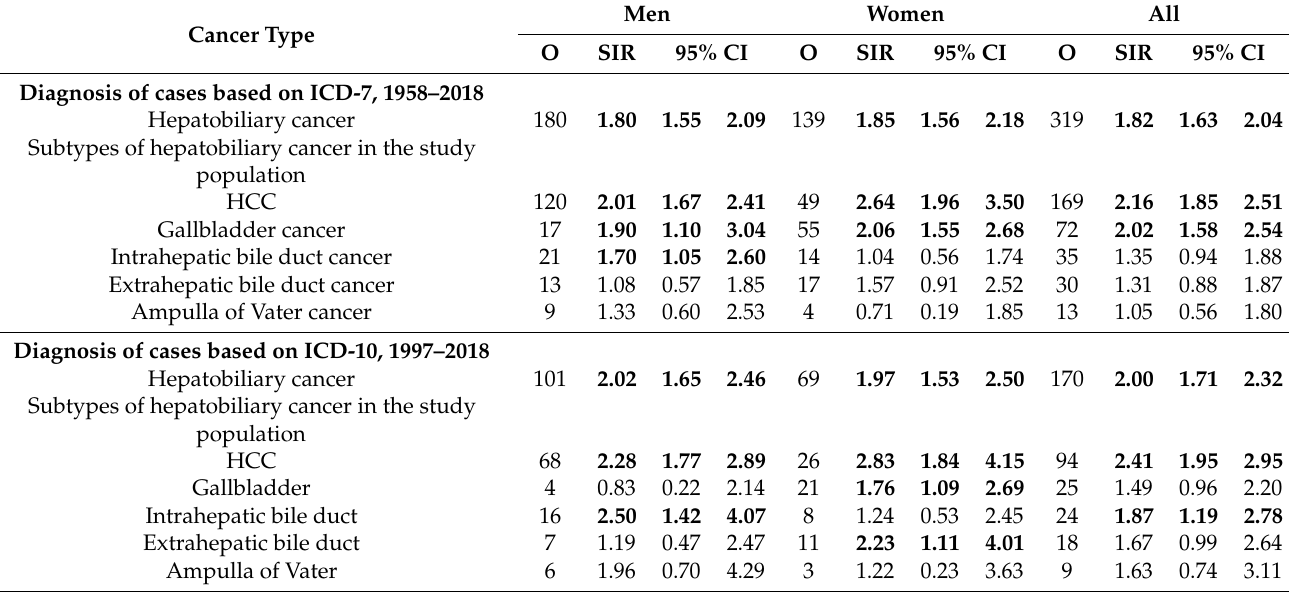
Table 2. Familial risks of hepatobiliary cancer when a first-degree relative had any type of hepatobil- iary